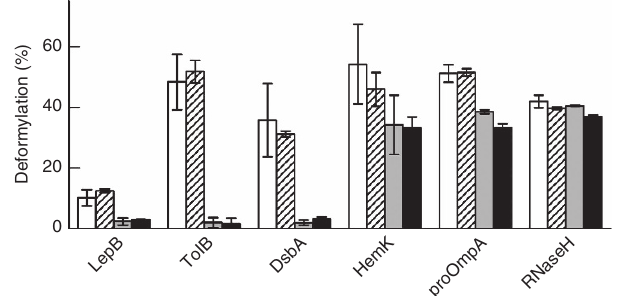
Figure 4 | No effect of trigger factor on deformylation and its inhibition by SRP. RNCs carrying nascent peptides of 75 amino acids were reacted with PDF without any addition (open bars), or in the presence of trigger factor (hatched bars; 3 m M), SRP (grey bars; 1 m M) or both (black bars). The extent of deformylation after 30min of incubation is plotted. Error bars represent s.e.m. ( n ¼